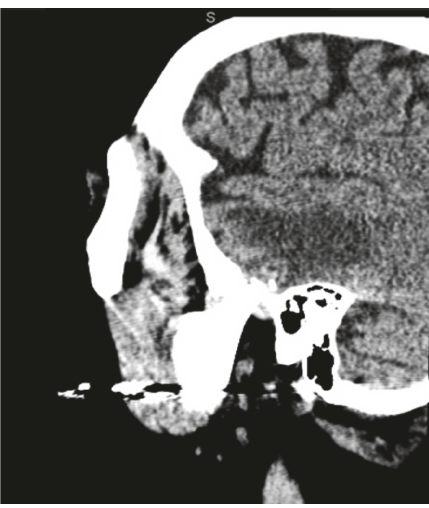
Figure 4: Soft tissue window sagittal CT illustrating intracranial edema surrounding the glenoid